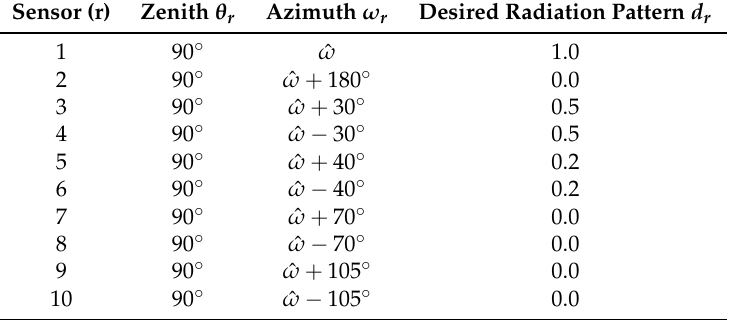
Table A2. Beamformer restrictions of the 2D-grid array (2D-GA) with 16 dipoles: ˆ ω is the generalized